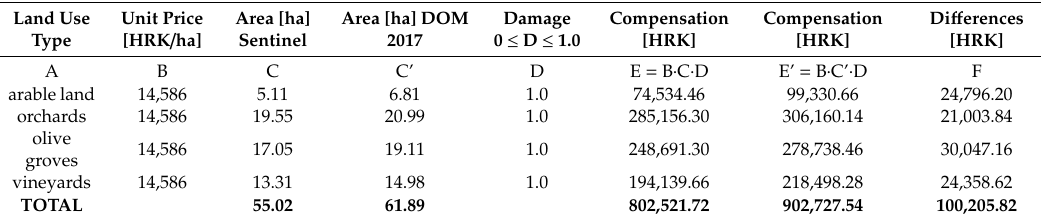
Table 2. Compensation by land use type according to the rulebook on the methodology for determining the market price for the sale of agricultural land owned [26].